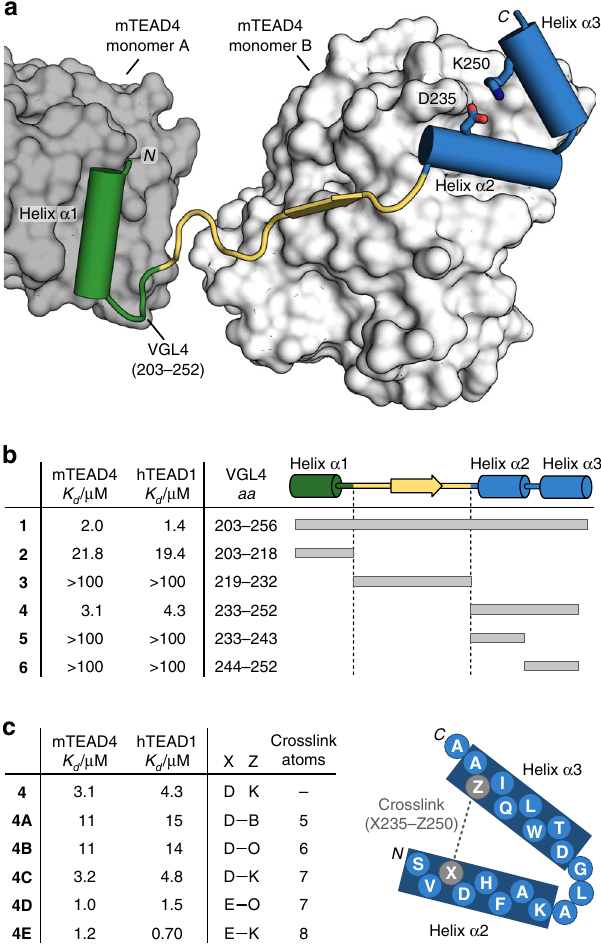
Fig. 1 Structure-based design was applied to stabilize a two-helix motif. a Crystal structure of the VGL4 – TEAD (PDB: 4LN0) 18 protein – protein interaction. Helix α 1 of VGL4 binds to TEAD monomer B while β -strand, helices α 2 and α 3 bind to TEAD monomer A. The two-helix motif